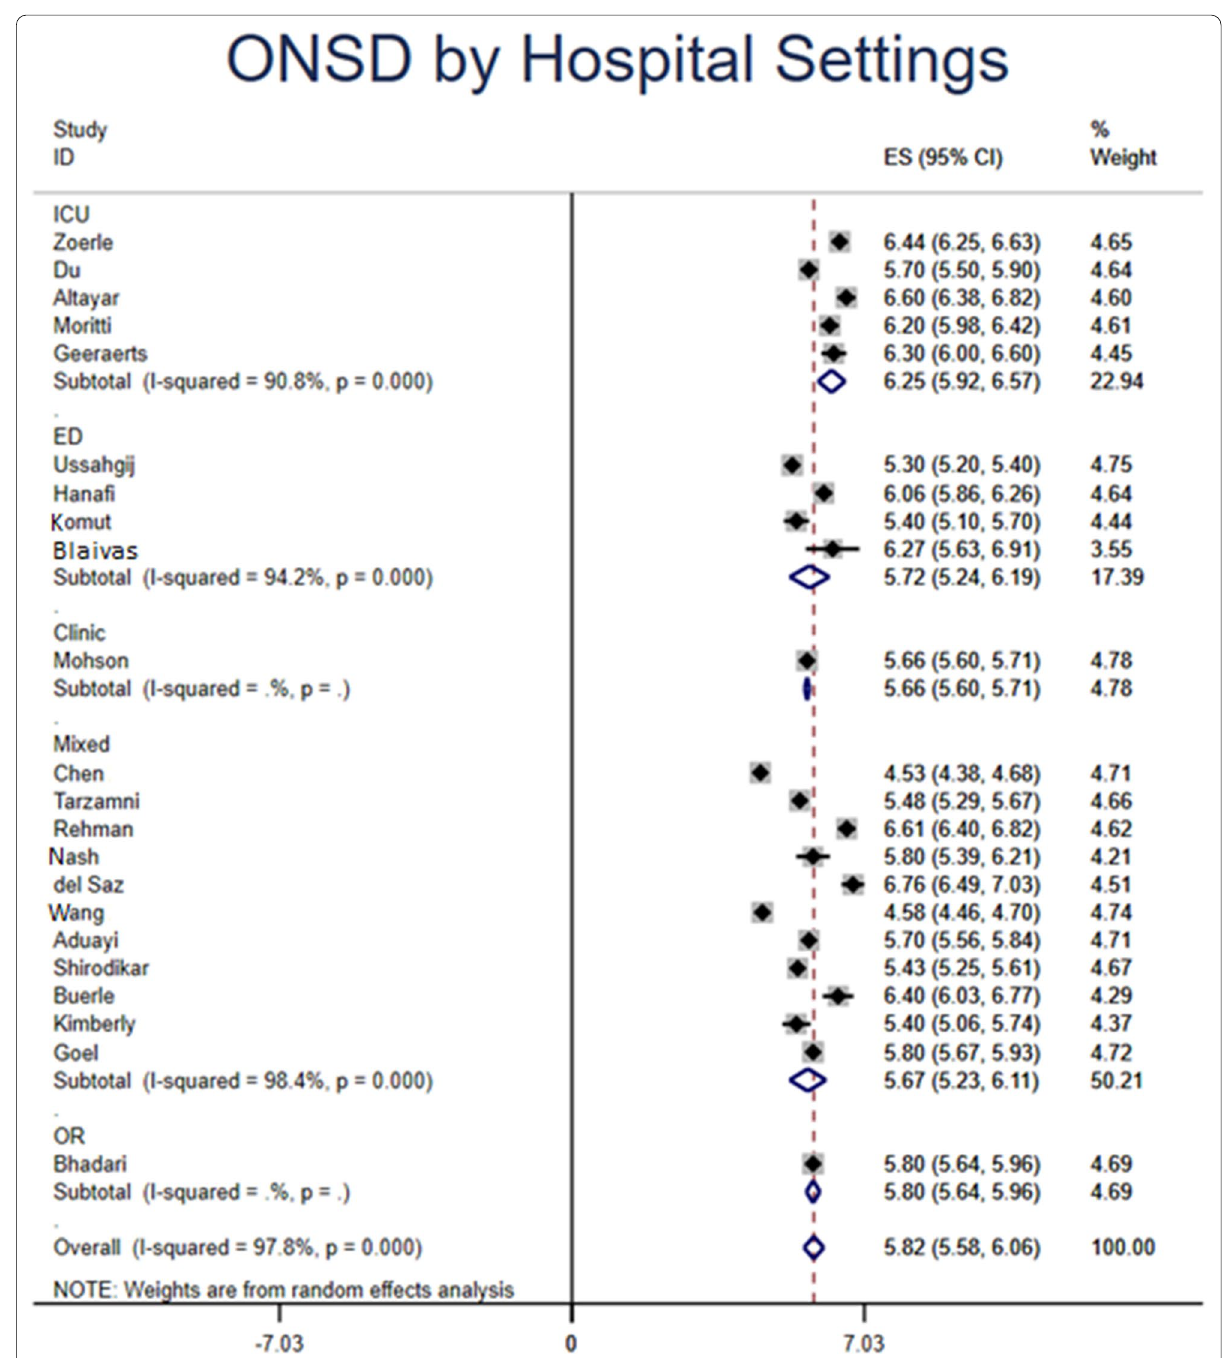
Fig. 3 Optic nerve sheath diameter (ONSD) measured by ultrasound (US) stratified by clinical settings where measurement was taken place. ICU Intensive care unit, ED Emergency Department, OR operating